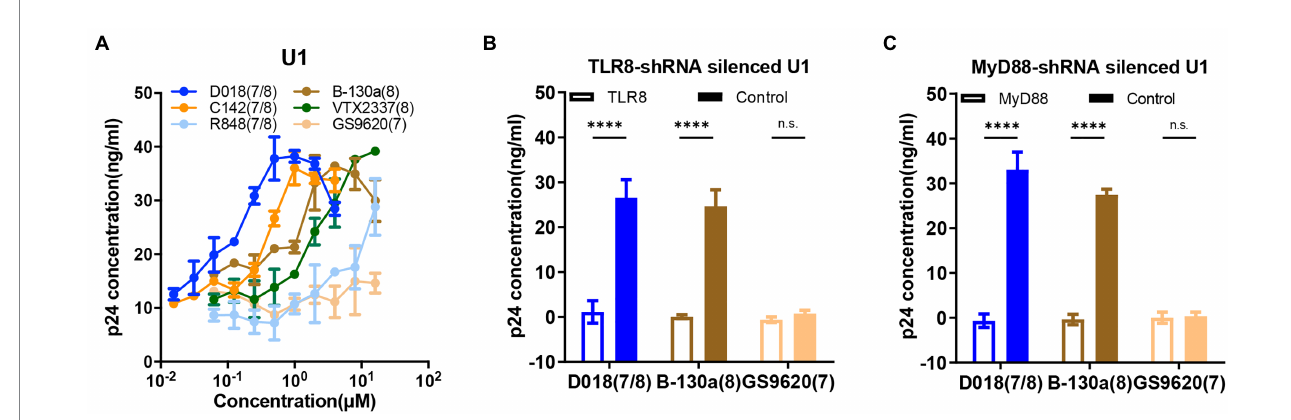
FIGURE 3 TLR7/8 agonists directly activate latent HIV-1 from monocytic U1 cell line. (A) Dose–response curves for HIV-1 activation in U1 cell line by the selected novel and control TLR7/8 agonists. Data are shown as mean ± SD ( n = 4). (B,C) The p24 concentration in the supernatant of U1 cell line stimulated by D018 (TLR7/8), B-130a (TLR8), or GS9620 (TLR8) before and after (B) TLR8-shRNA silencing or (C) MyD88-shRNA silencing compared with control shRNA silencing. Data are shown as mean ± SD ( n = 4). Statistical difference between various TLR7/8 agonists was analyzed by two-way ANOVA. **** p < 0.0001,